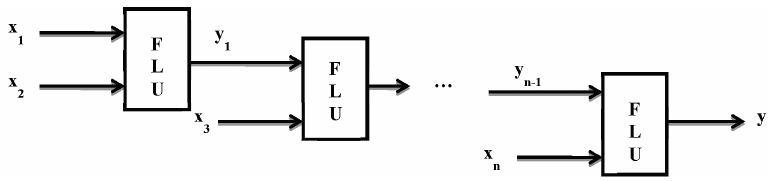
Figure 22. Typical structure of hierarchical fuzzy system.